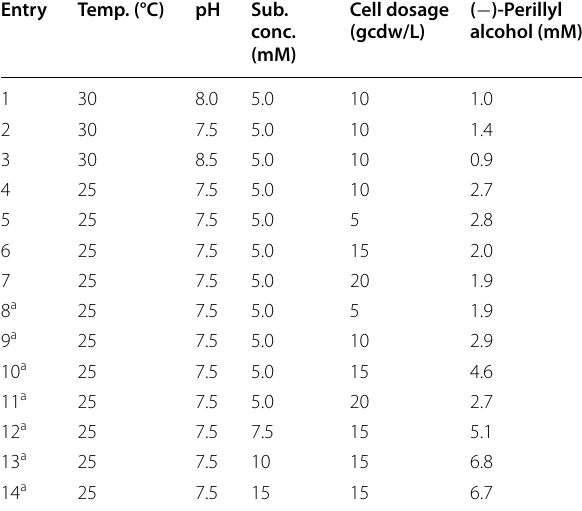
Table 1 Optimization of reaction conditions of Module